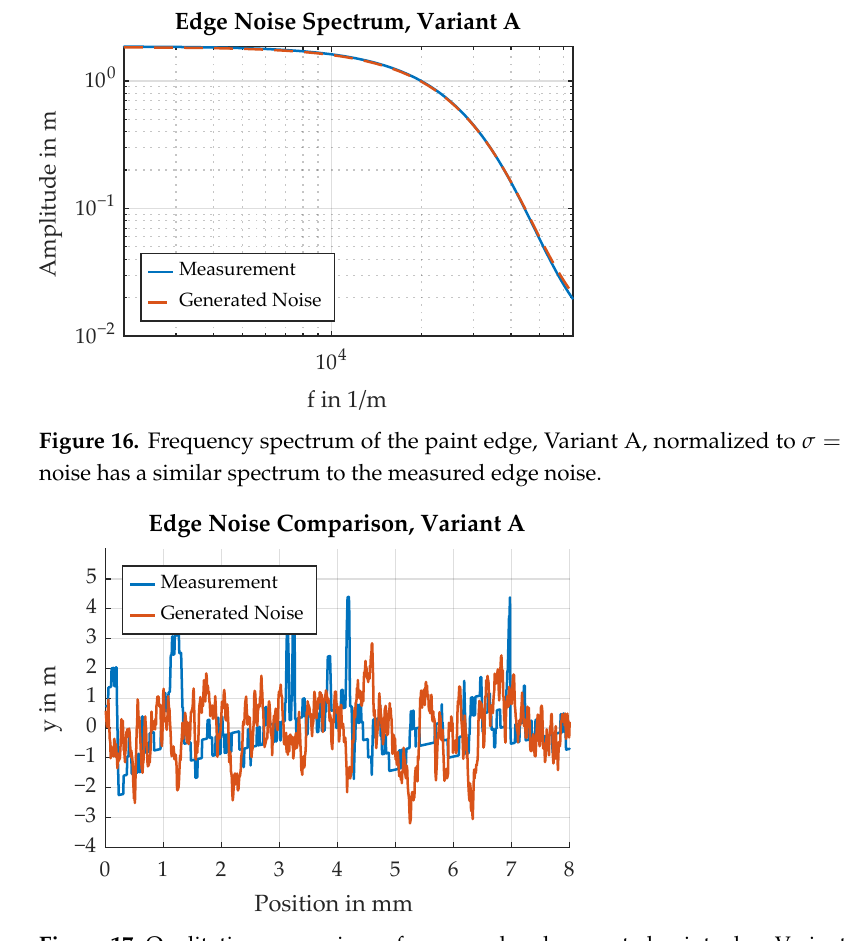
Figure 17. Qualitative comparison of measured and generated paint edge, Variant A, normalized to σ = 1.